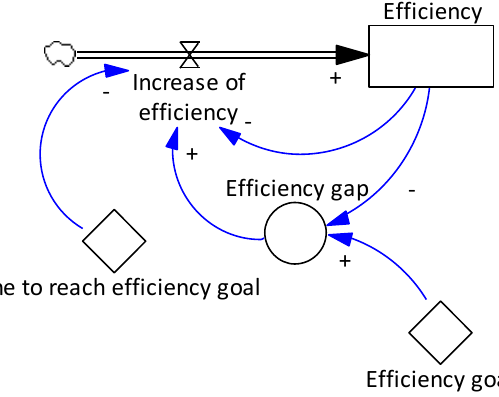
Fig. 3. A stock-and-flow diagram representing change of the efficiencies of technologies (light bulbs, household electric appliances, heat pumps, air conditioners) and specific (per unit of living area) heating/cooling consumption. Increase of the electricity cost-income ratio (Fig. 4) motivates a certain fraction of households to replace old light bulbs and electric appliances which still could be operated with the new ones, i.e. at a rate which is faster than would be required if following the normal lifetime of those